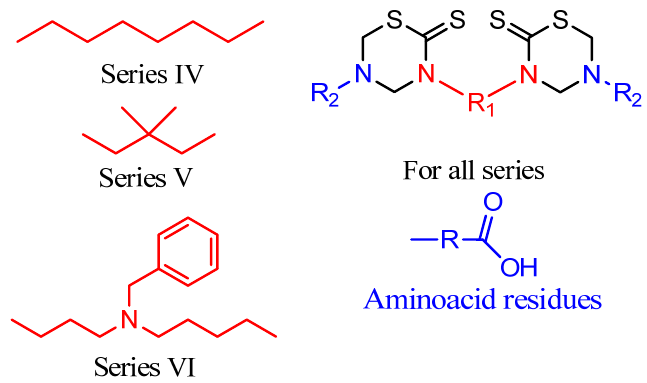
Figure 6. Bis - THTT derivatives with antiprotozoal